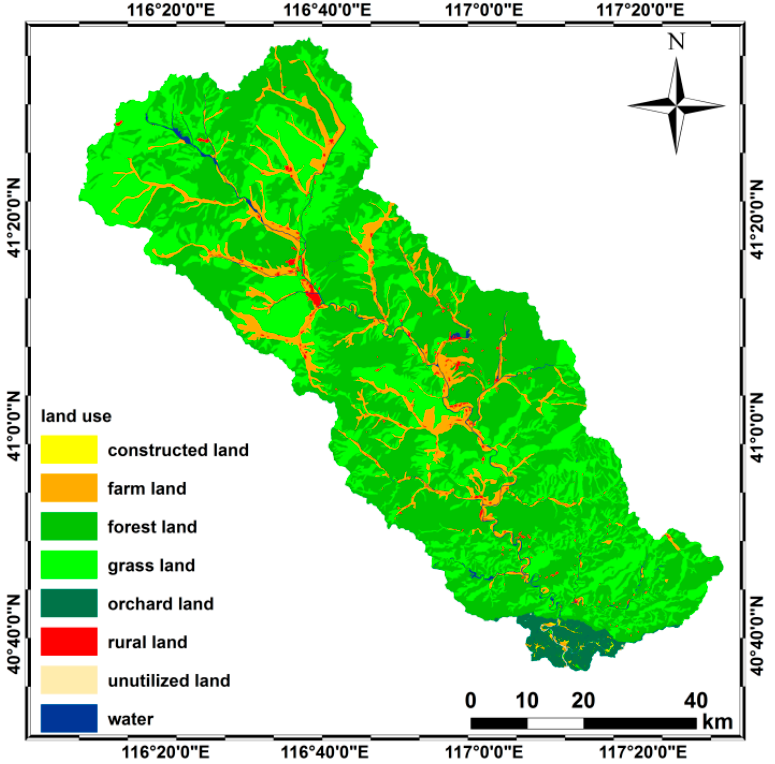
Figure 2. Land use of the upper watershed of the Miyun reservoir.